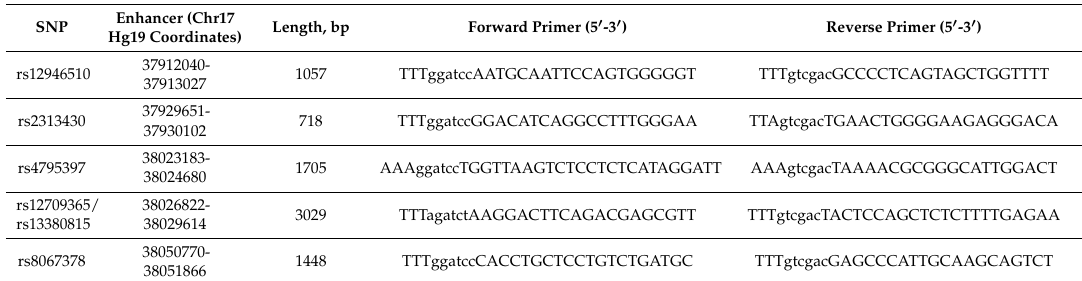
Table 1. Primer sequences used for enhancer cloning.